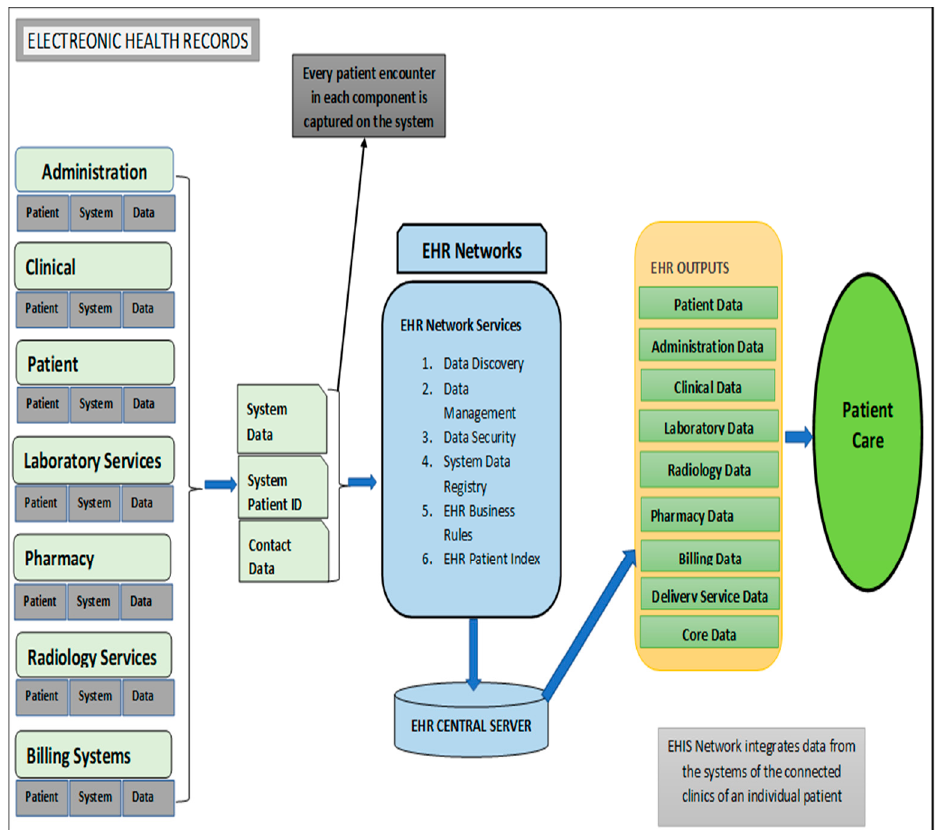
Figure 1. Overview of electronic health information system components (adapted from the National Institute of Health National Center for Reasearch Resources; 2006 [13]).